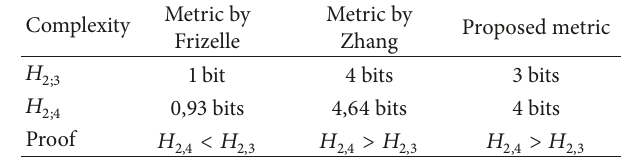
Table 4: Proofs of Rule #1.